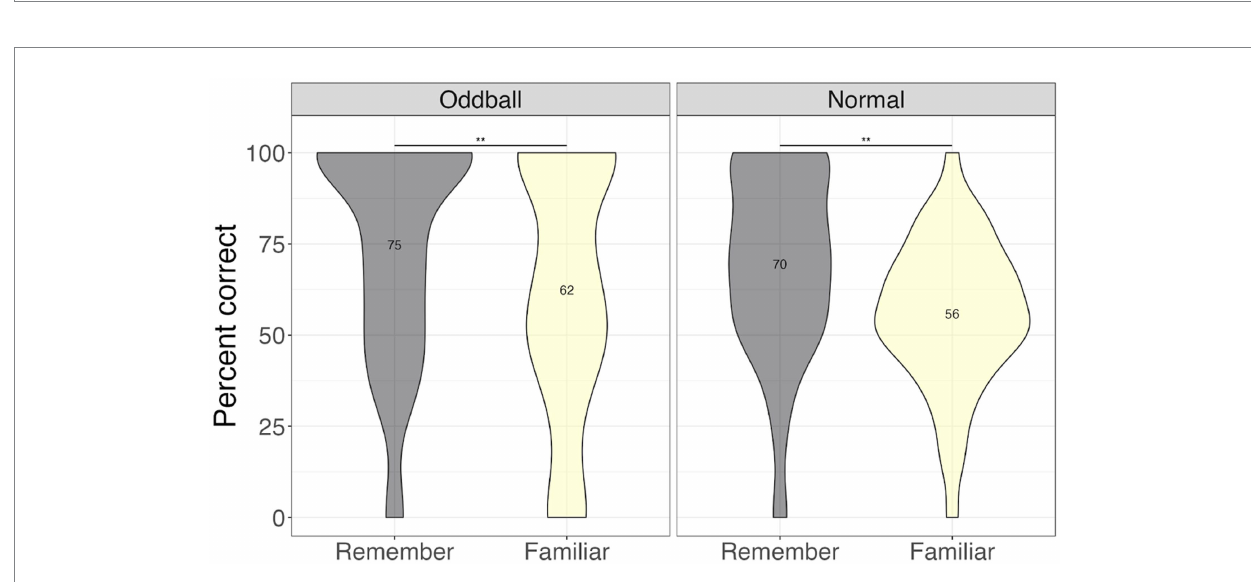
FIGURE 7 Percent correct for location test by self-reported confidence levels in Experiment